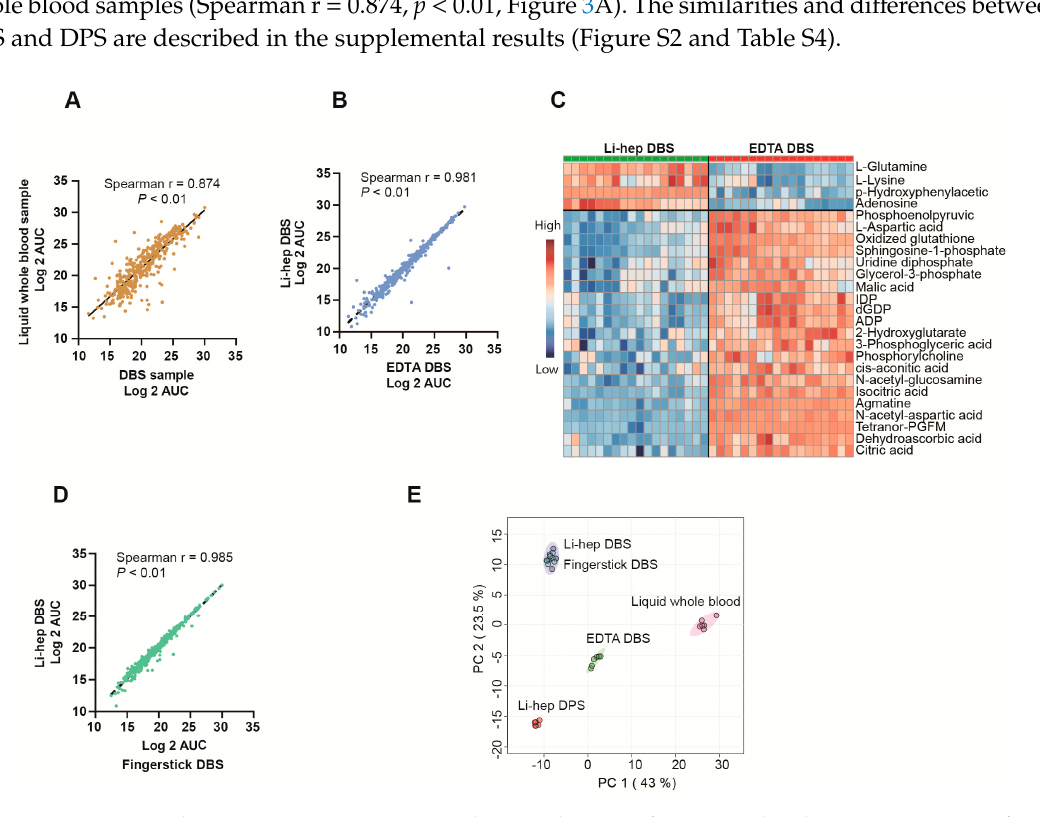
listed. p < 0.01. ( D ) The correlations of metabolite AUCs between Li-hep DBS and fingerstick